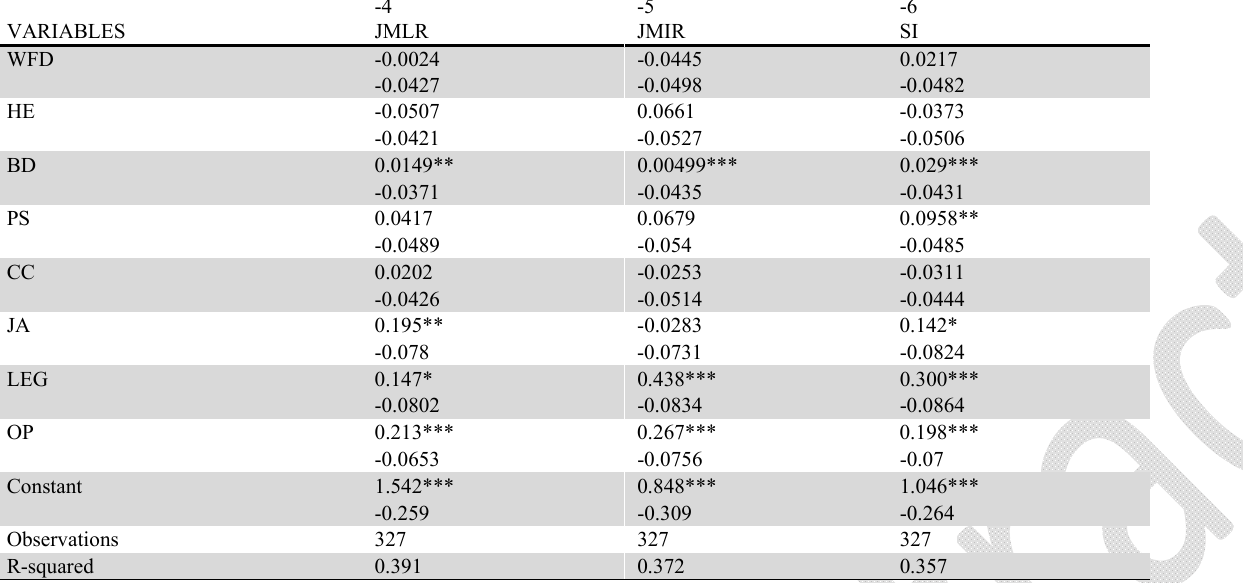
Empirical Findings for last three indicators of education Management and Public Policy -4 -5